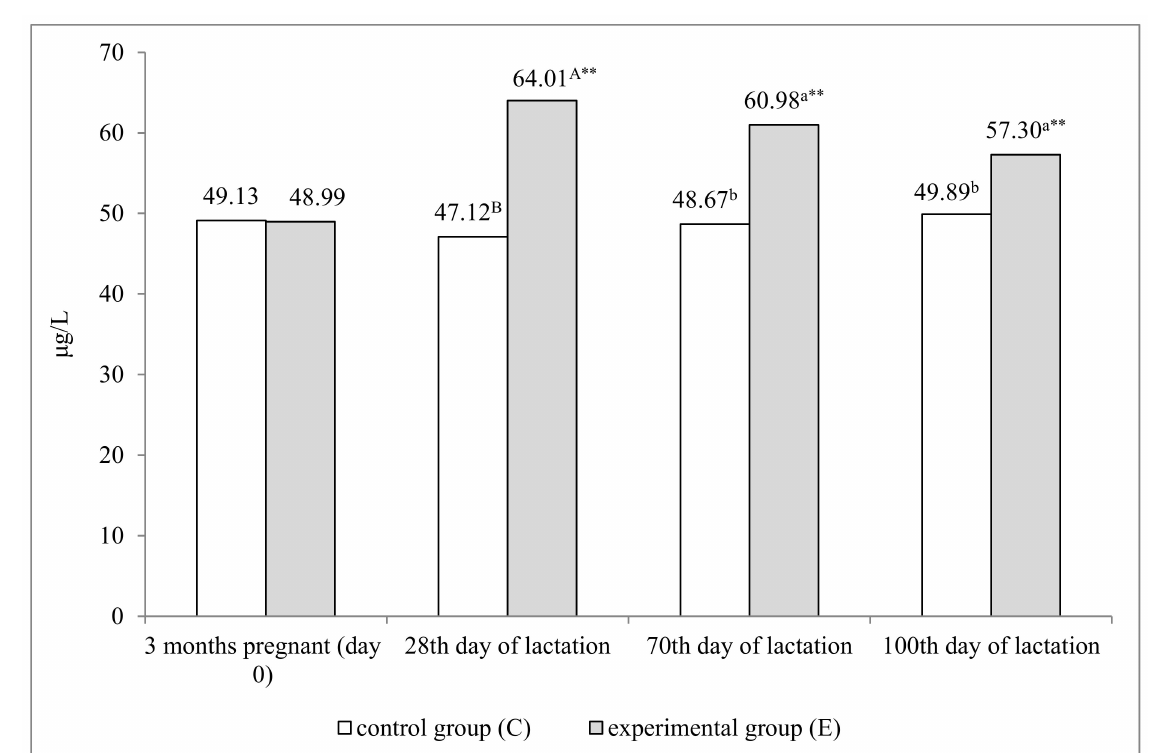
Figure 1. Serum Se concentration in dams from control group C and experimental group E ( µ g/L) a, b— p ≤ 0.05; A, B— p ≤ 0.01. ** p ≤ 0.01—significant difference relative to day 0 (3 months